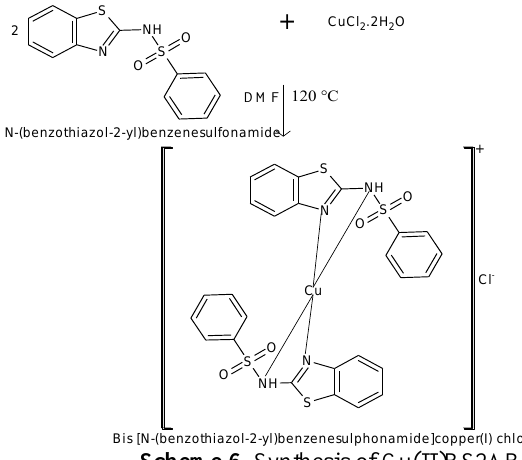
Scheme 6. Synthesis of